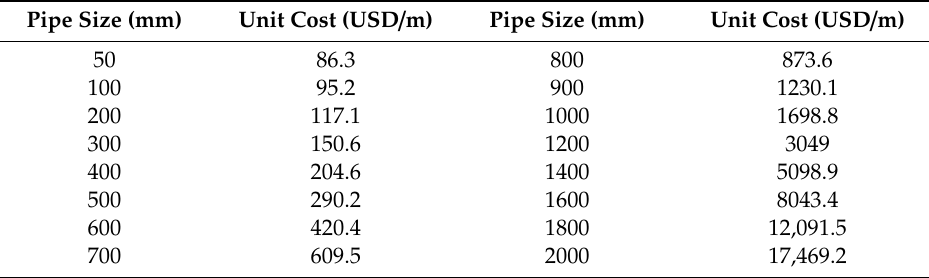
Table 1. Available commercial pipe sizes and corresponding unit